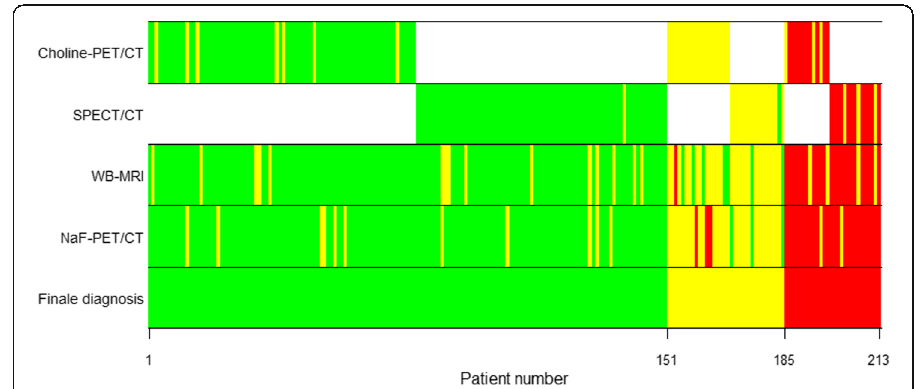
Fig. 4 The results of the index tests and the final diagnosis for each study participant represented by a column. Colour codes: green = no metastases, yellow = 1 – 5 bone metastases, red = > 5 bone metastases, white = imaging method not